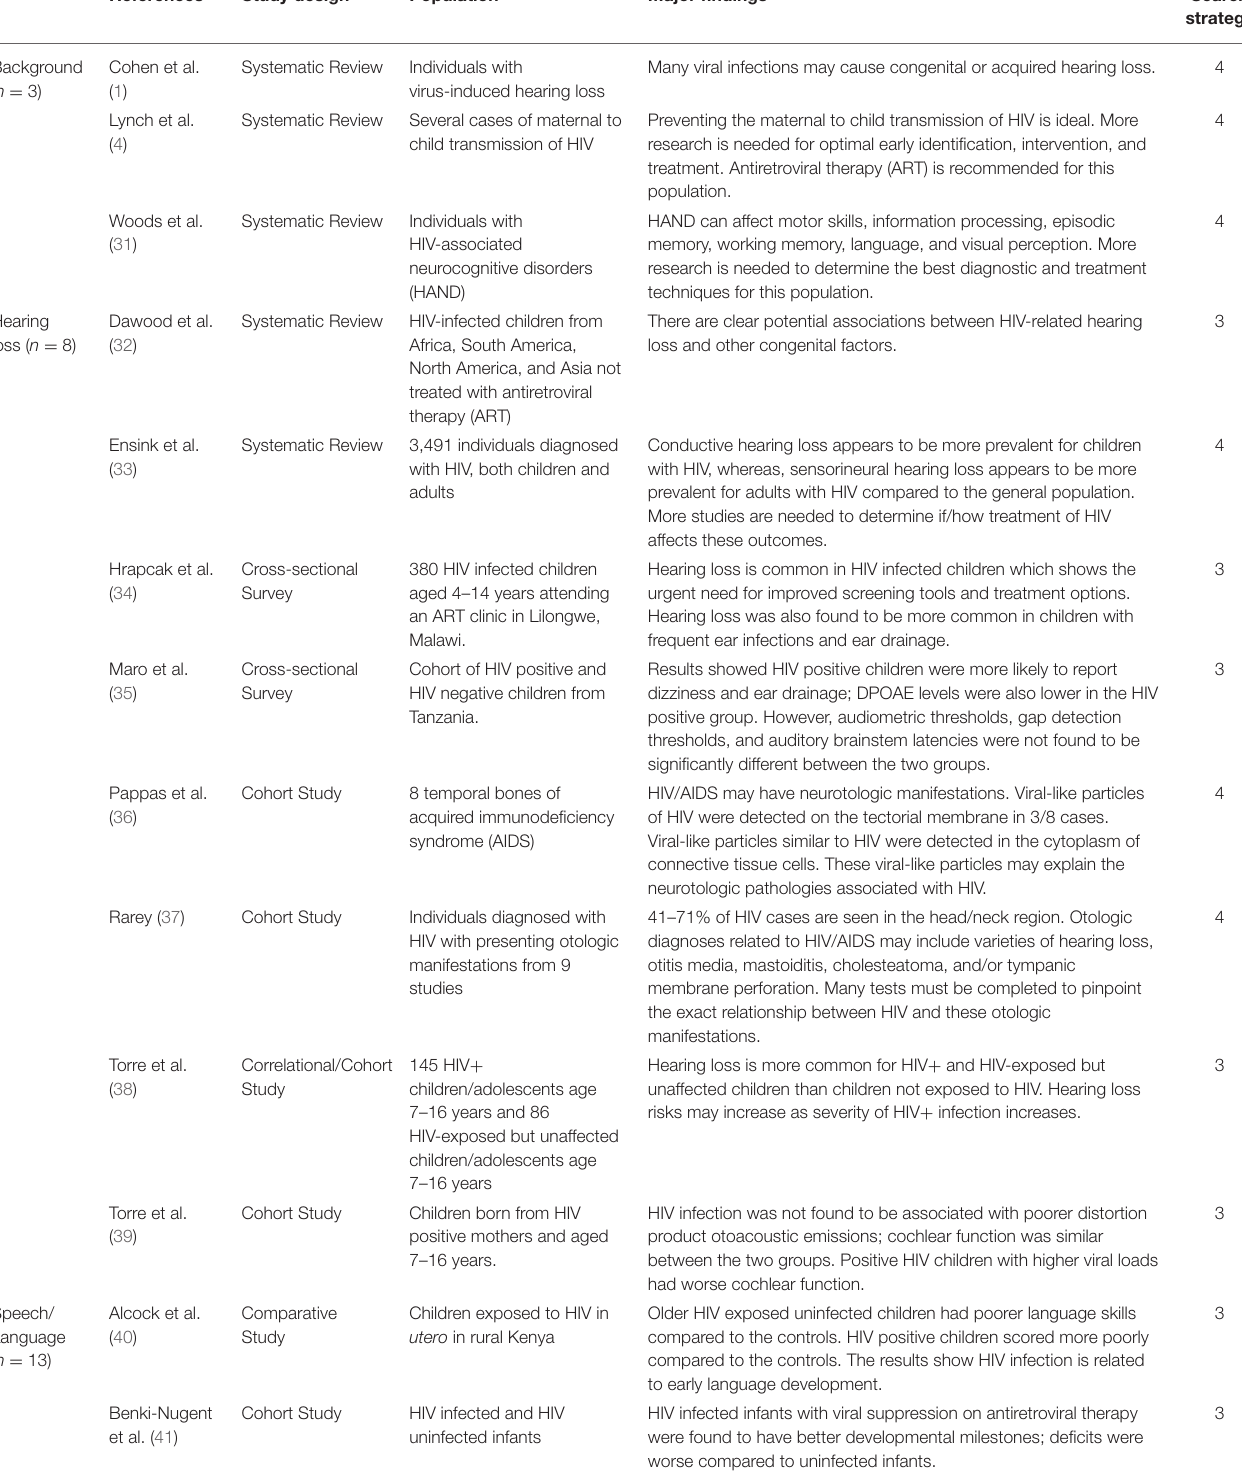
TABLE 2 | Background of HIV and effects of HIV on hearing and speech and language development in